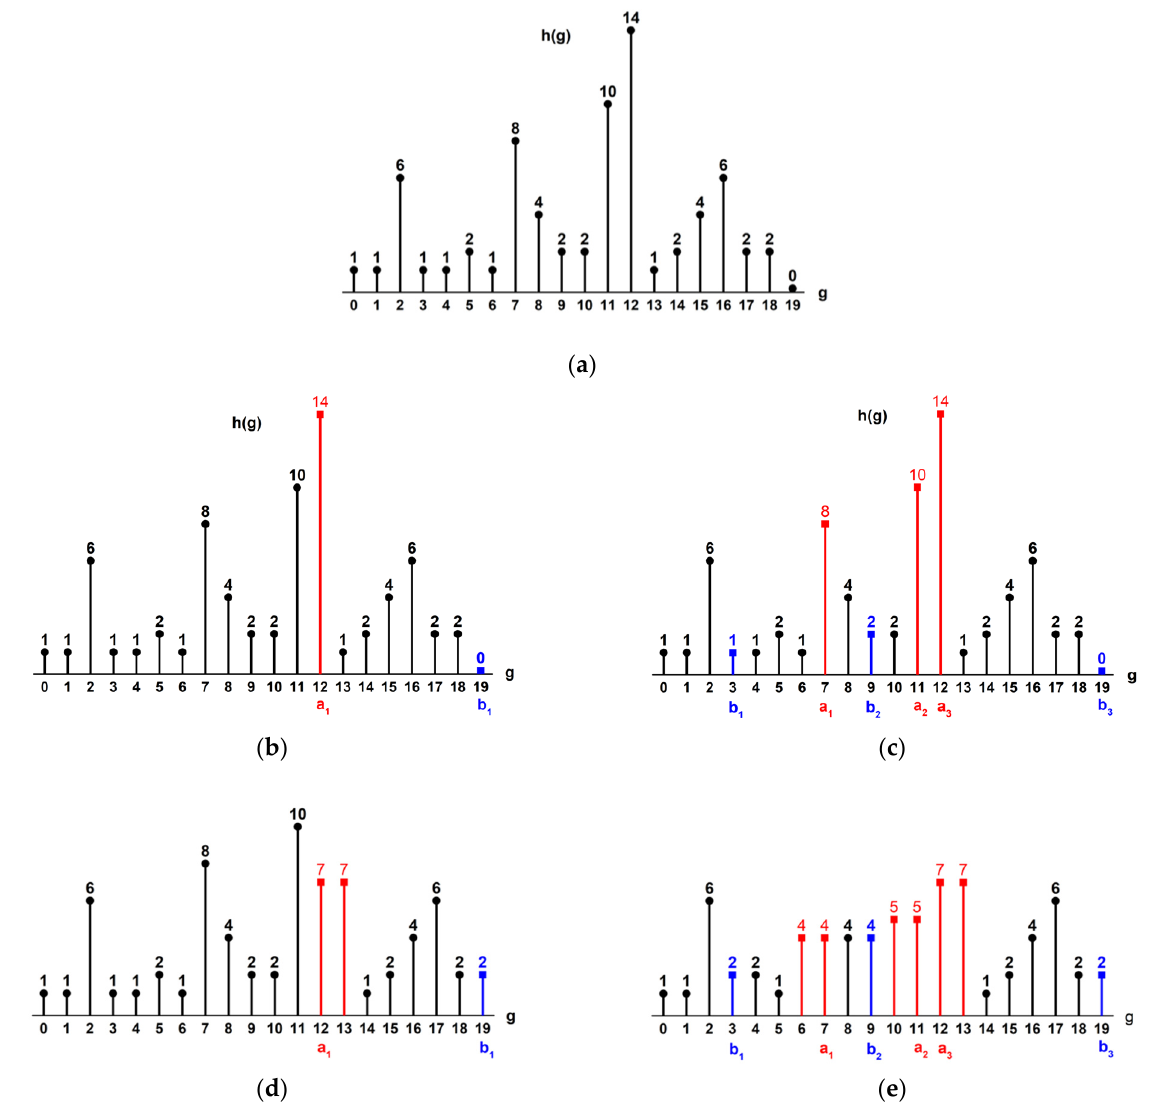
Figure 7. ( a ) Example of a histogram; ( b ) one range selected with capacity equal to 14 bits; ( c ) three ranges selected with total capacity equal to 20 bits; ( d ) Histogram with concealed information in the range of ( b ); ( e ) Histogram with concealed information in the three ranges of ( c ). Optimization